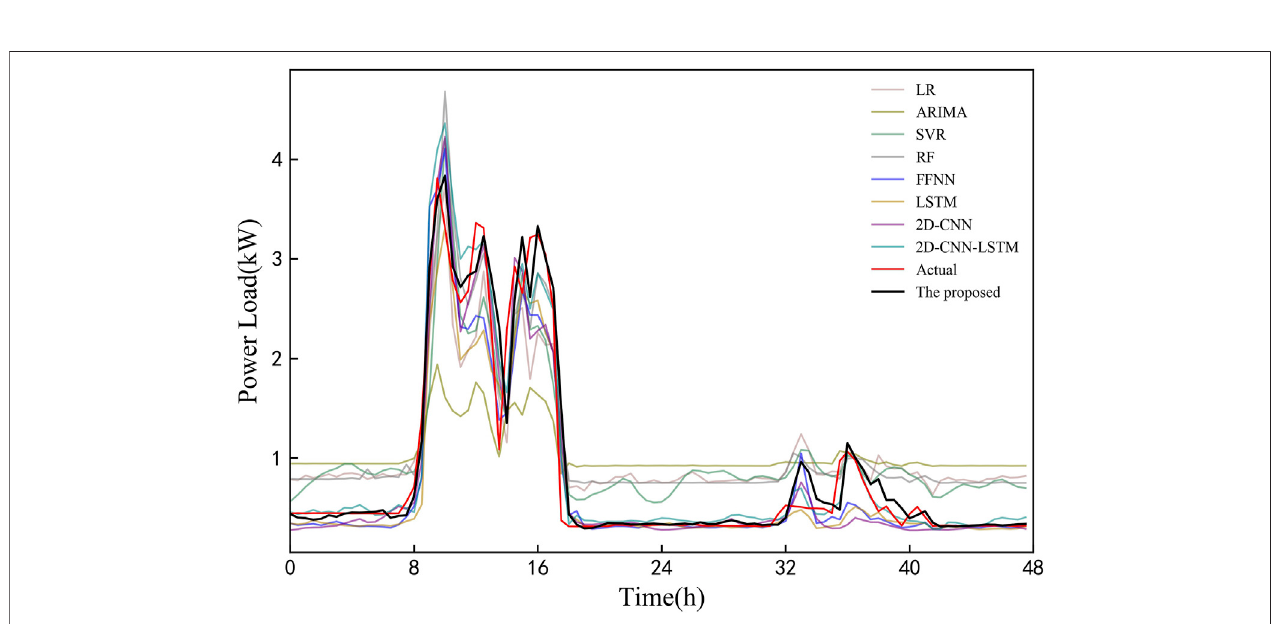
FIGURE 14 | Load forecasting pro fi les of all models in experiment